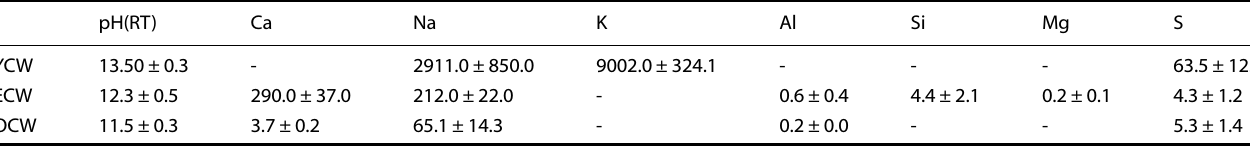
Table 5. Composition of synthetic cement waters (mg L − 1 ), as determined by ICP-OES. pH(RT) Ca Na K Al Si Mg S YCW 13.50 ± 0.3 - 2911.0 ± 850.0 9002.0 ± 324.1